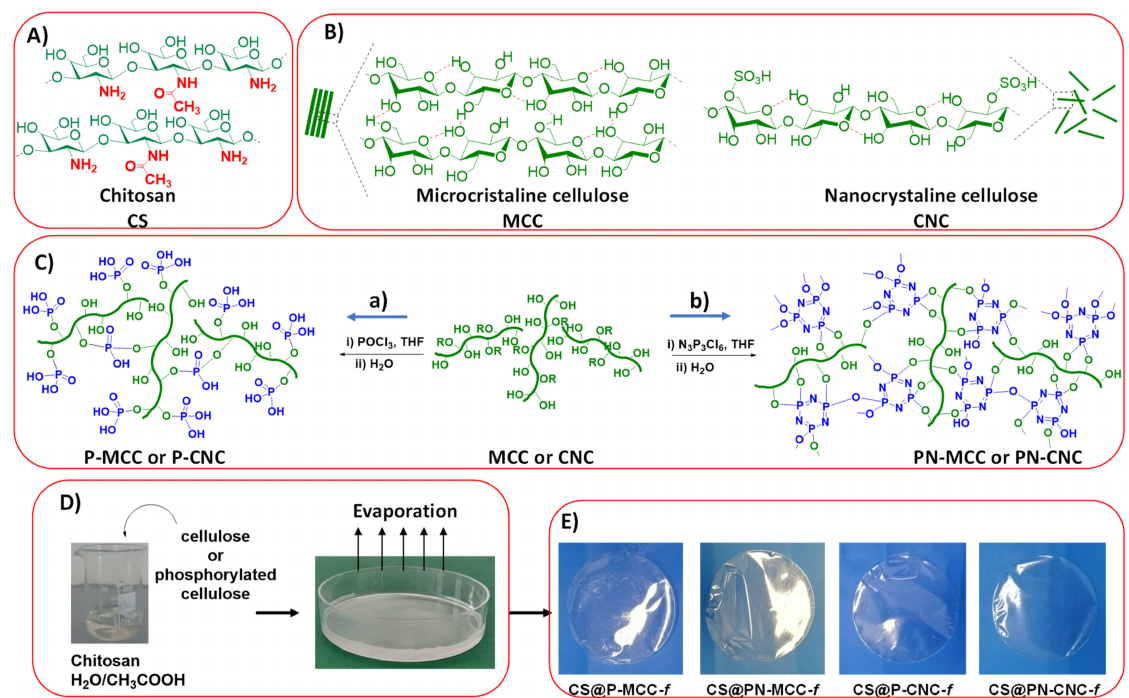
Figure 1. Multistep preparation of cellulose-filled chitosan films. ( A ) the chemical structure of chitosan used to generate flexible and transparent films; ( B ) the structure of the two cellulose fillers used to reinforce chitosan, namely microcrystalline cellulose (MCC) with tactoids and isolated tiny crystals of nanocellulose (CNC); ( C ) the use of two different phosphorylated reagents (POCl 3 or N 3 P 3 Cl 6 ) affords two kinds of phosphorylated cellulose (P-MCC/P-CNC and PN-MCC/PN-CNC); ( D ) mixing of chitosan and cellulose derivative followed by the introduction of the resulting solution in a petri dish and further evaporation of the solvent; ( E ) digital photos of the resulting cellulose-filled chitosan films, illustrating their